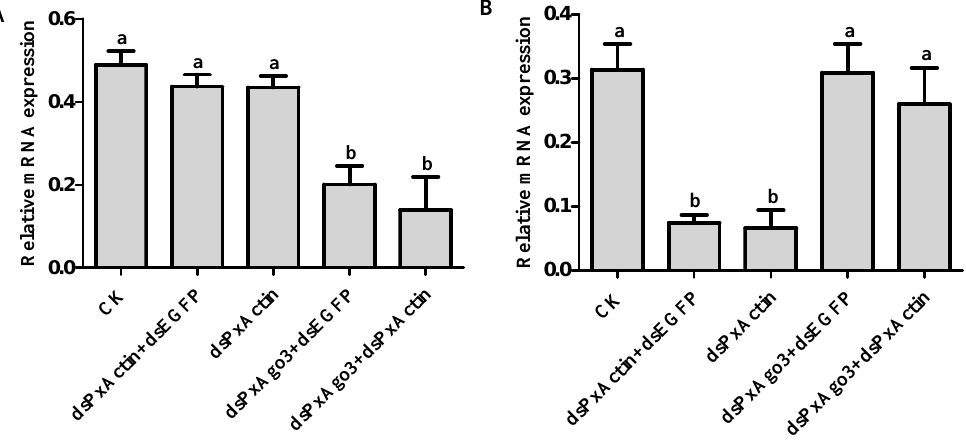
Figure 5. Effects of PxAgo3 knockdown on PxActin suppression in P. xylostella cells. ( A ) PxAgo3